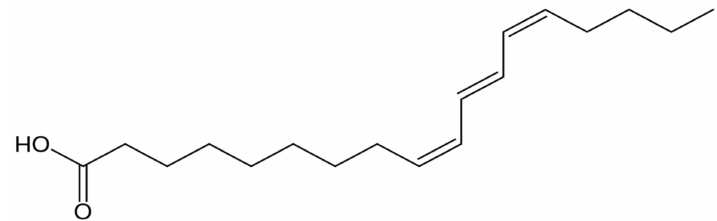
Figure 1. Chemical structure of punicic